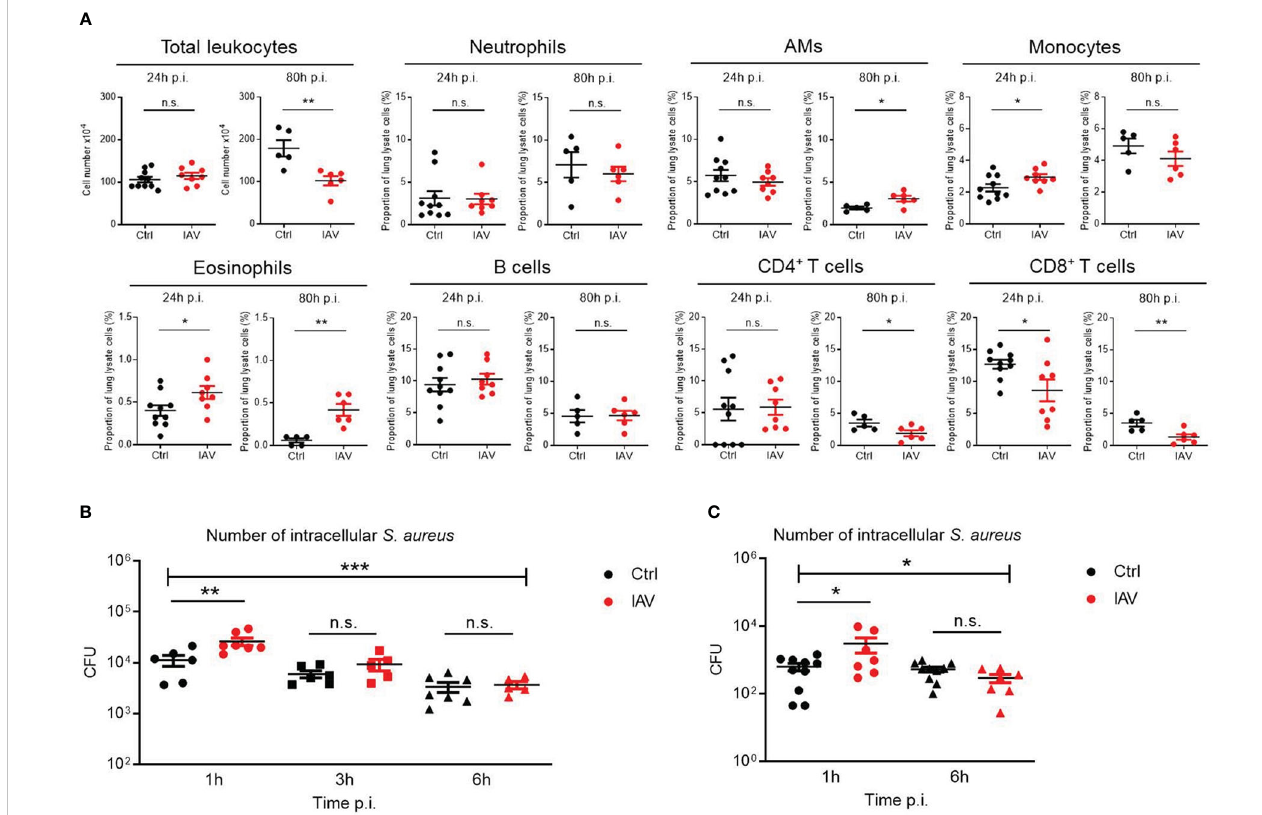
FIGURE 3 Silent neonatal IAV infections train phagocyte functions against S. aureus infections. Experimental setup as illustrated in Figure 1A. (A) After 24 h and 80 h of infection of d21 mice with S. aureus , the total number of leukocytes and the proportion of indicated leukocytes harvested from the lungs were determined by fl ow cytometry in the Ctrl and IAV pretreatment group (each group n = 5-10 from 2 litters, respectively). Plotted are means ± SEM, *p < 0.05 (MWU test). (B, C) Bacterial phagocytosis and killing capacity of blood-derived macrophages (B) and BMDMs (C) obtained from d21 mice after neonatal i.n. pretreatment with PBS or 5 PFU of IAV (each group n = 7-10 from 2 litters, respectively). Plotted are the numbers of colony-forming units (CFU) of intracellular S. aureus at 1 h, 3 h and 6 h (in blood-derived macrophages) respective 1 h and 6 h (in BMDMs) after ex vivo infection of macrophages at MOI 10. Bars represent means ± SEM. Signi fi cant differences were determined by ANOVA across settings (***p < 0.0001, *p < 0.05) and by post hoc ANOVA Tukey ’ s multiple comparison tests between pretreatment groups at resp. time points p.i. (**p < 0.005, *p < 0.05). n.s., not signi fi